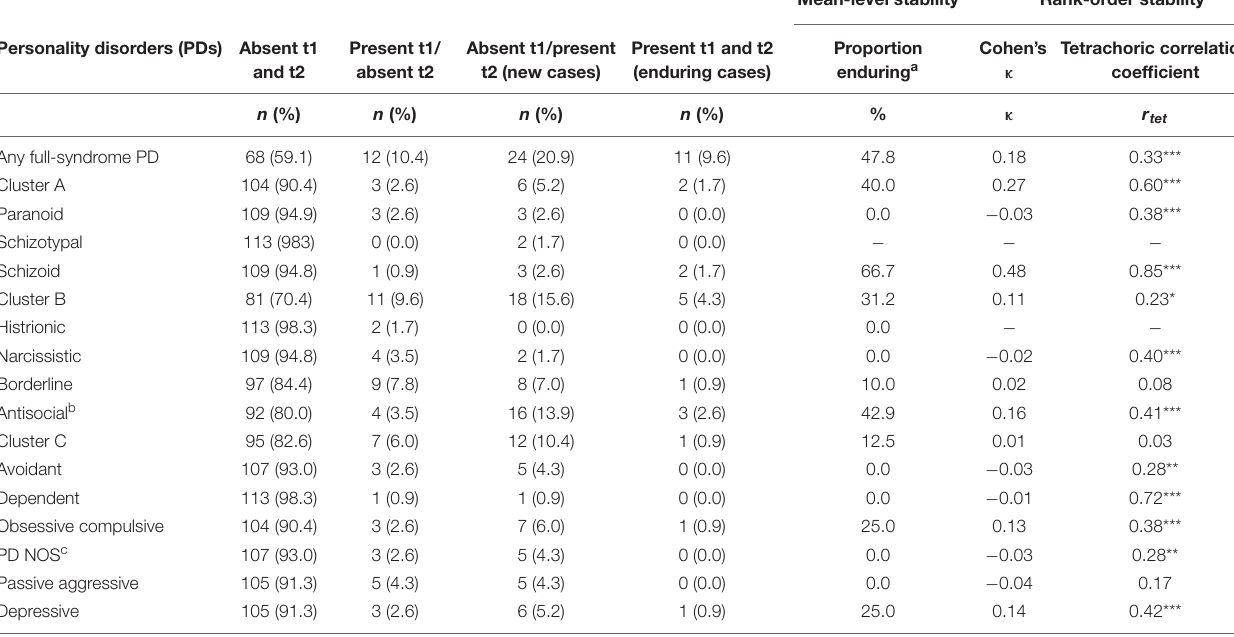
Mean-level stability Rank-order